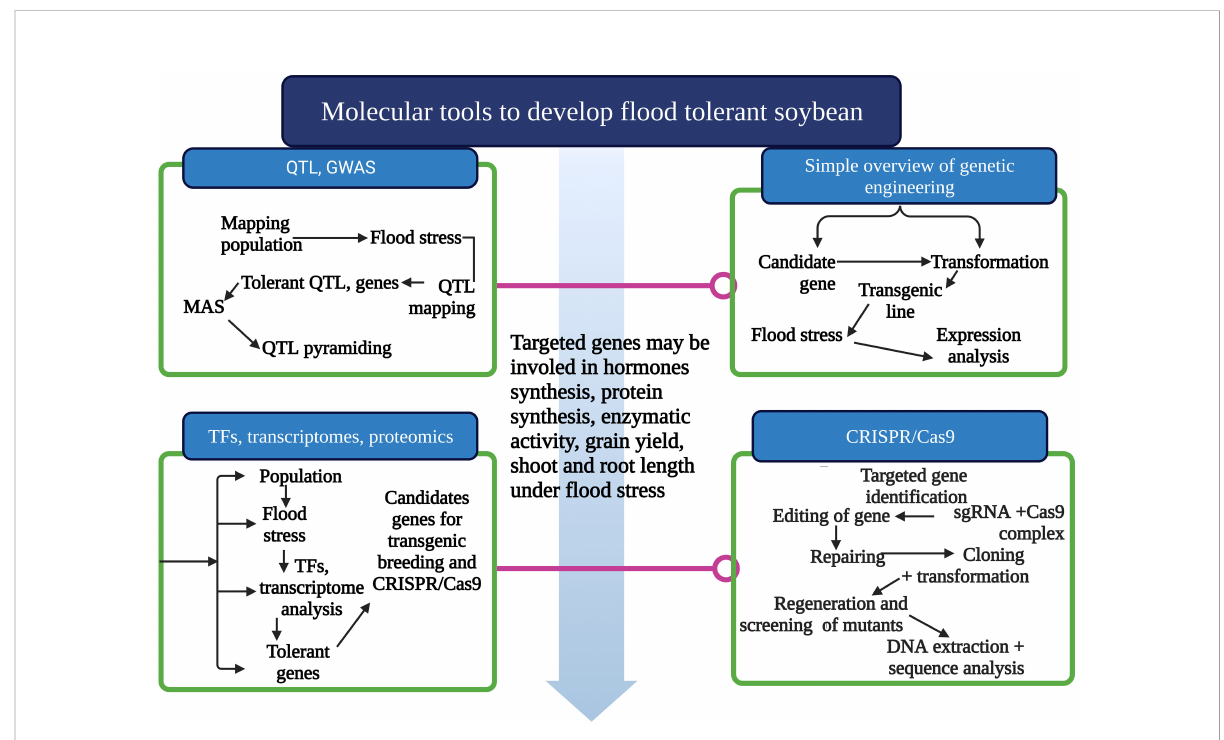
FIGURE 3 One of the most signi fi cant and consistent ways to develop fl ood-tolerant soybean varieties is using molecular breeding tools. CRISPR/Cas9 is a new and in fl uential gene manipulation tool among all molecular breeding tools. This tool can develop fl ood-tolerant cultivars and bring agricultural revolution. This Figure is created with